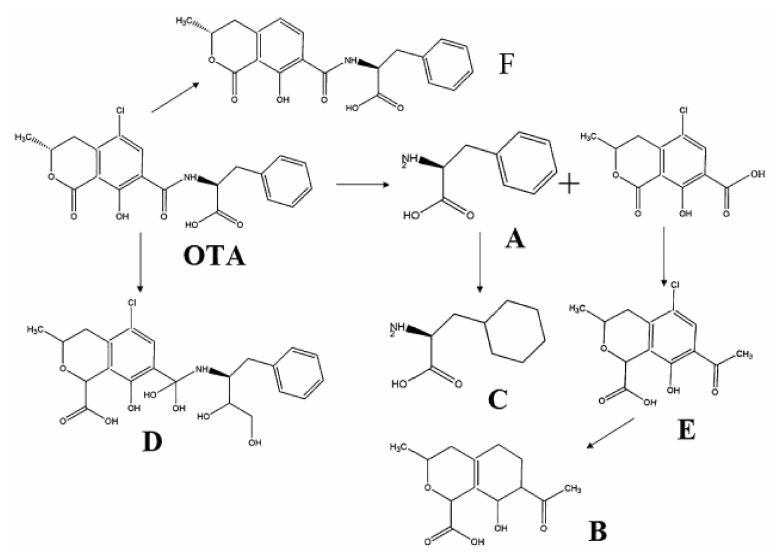
Figure 5. Degradation pathways of ochratoxin A (OTA) into six fragments using electron beam